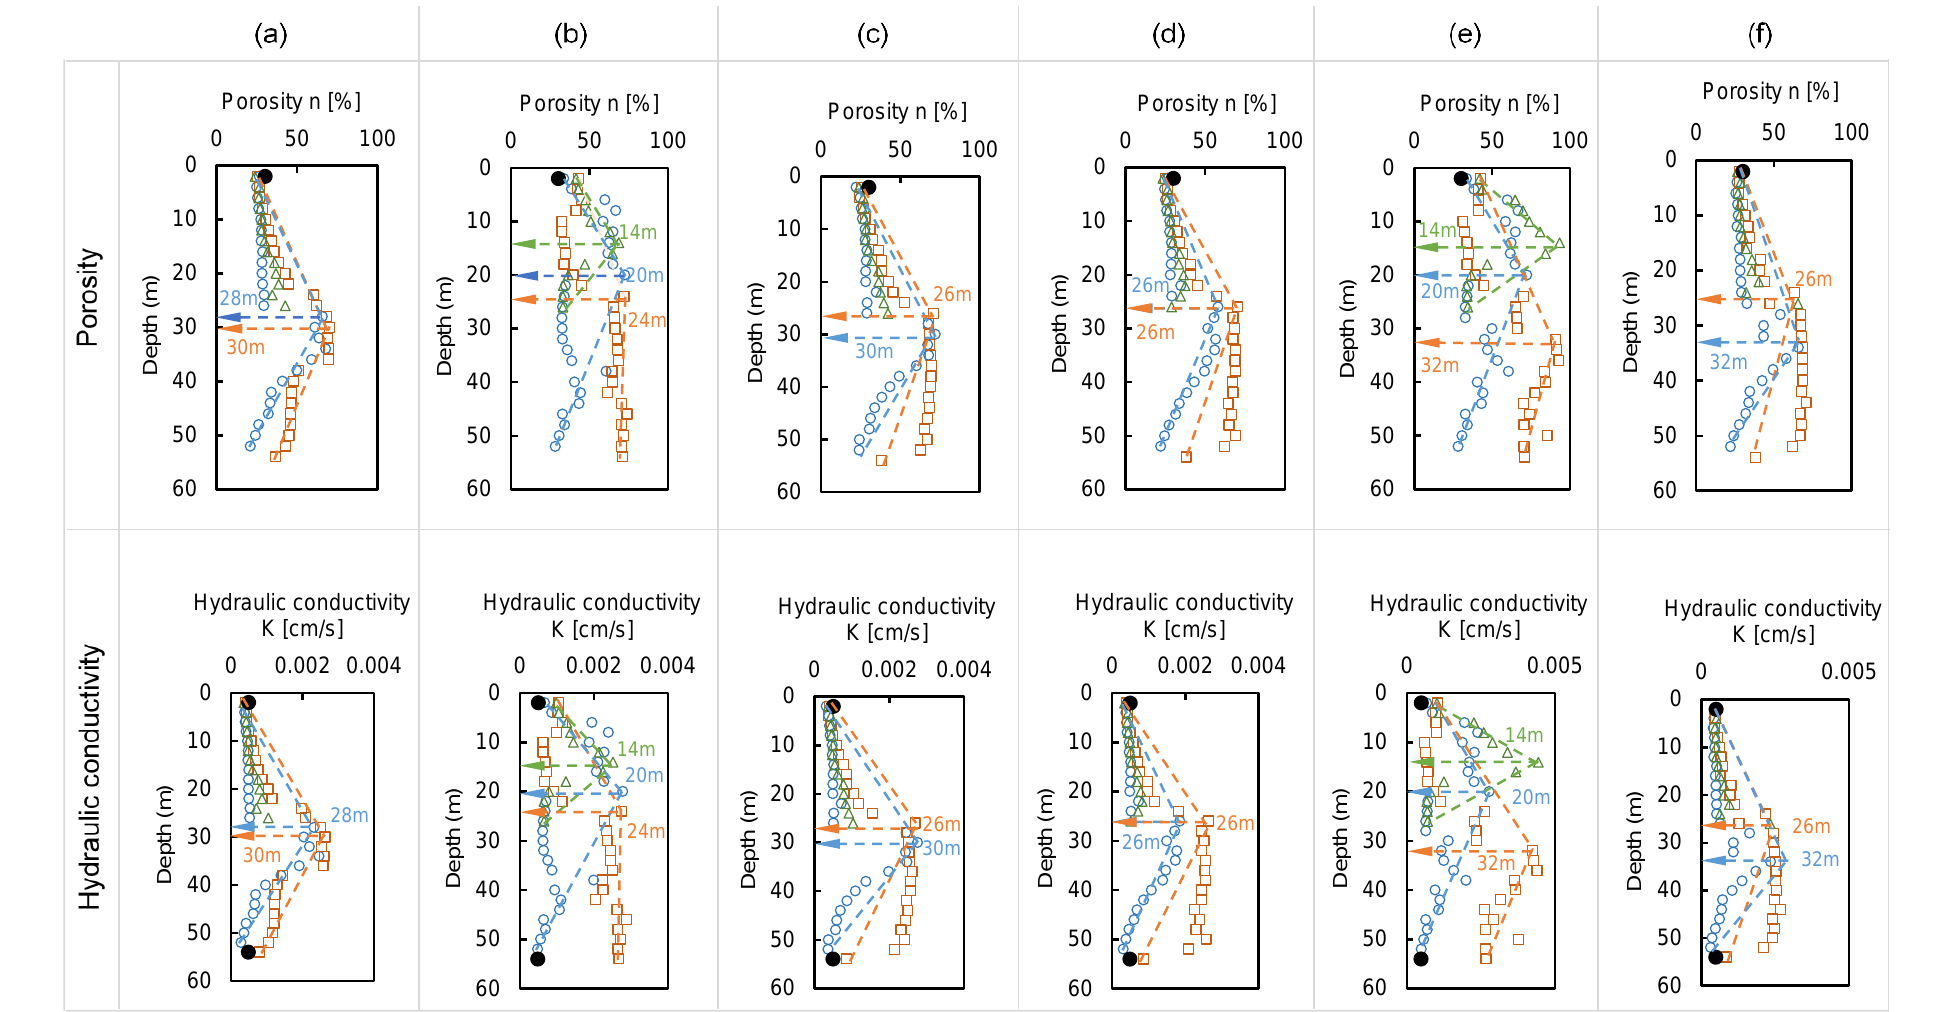
Figure 13. Discontinuity depth assessment based on porosity and hydraulic conductivity: ( a ) February 2019; ( b ) July 2019; ( c ) May 2020; ( d ) June 2020; ( e ) July 2020; ( f ) August 2020. The blue circles, red rectangles, and green triangles denote 80 m, 120 m, and 160 m horizontal distance, respectively, and each symbol is connected with a dotted straight line. The solid circles with black color indicate the measured values.